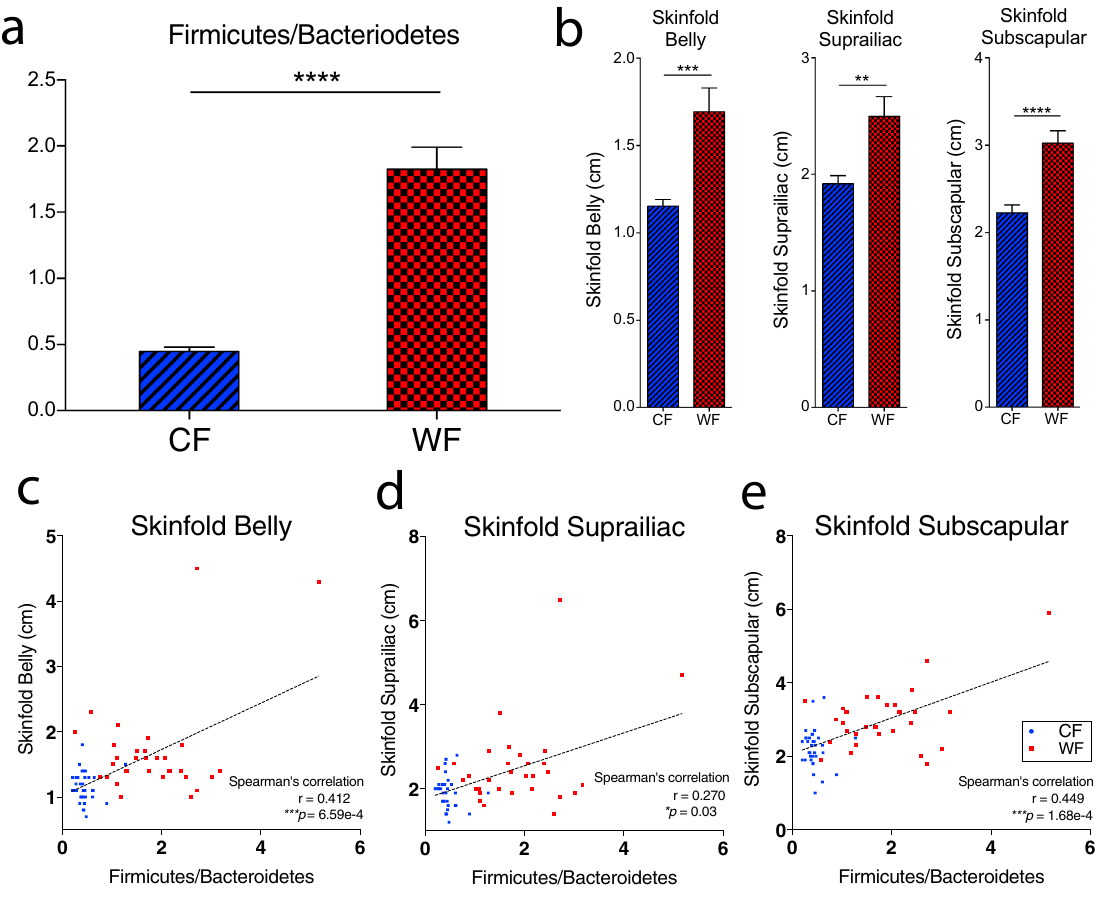
Figure 5. The relationship of Firmicutes/Bacteroidetes ratio in fecal microbiome and body fat accumulations in long-tailed macaque. ( a ) The difference of Firmicutes/Bacteroidetes ratio (mean ± SEM) between wild and captive was compared by t -test. (* P < 0.05, ** P < 0.01, *** P < 0.001, **** P < 0.0001). ( b ) The bar graph shows the measurement of skinfold indicated body fat (mean ± SEM) in wild and captive macaques compared